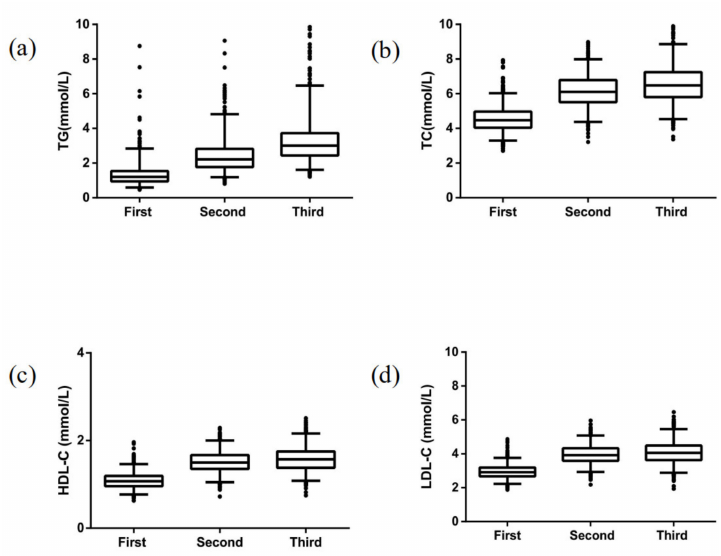
Figure 1. Lipid profile of women during pregnancy across three trimesters ( a ) TG concentrations across three trimesters, ( b ) TC concentrations across three trimesters, ( c ) HDL-C concentrations